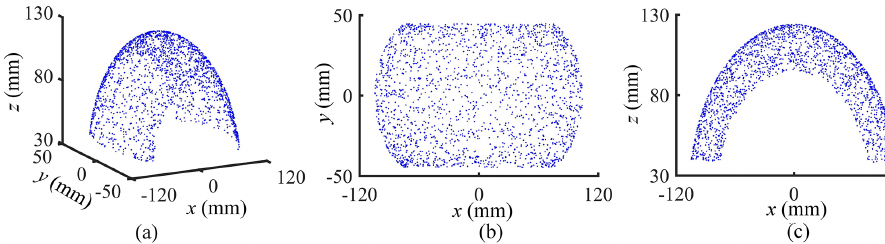
Figure 6. The workspace of the series unit.